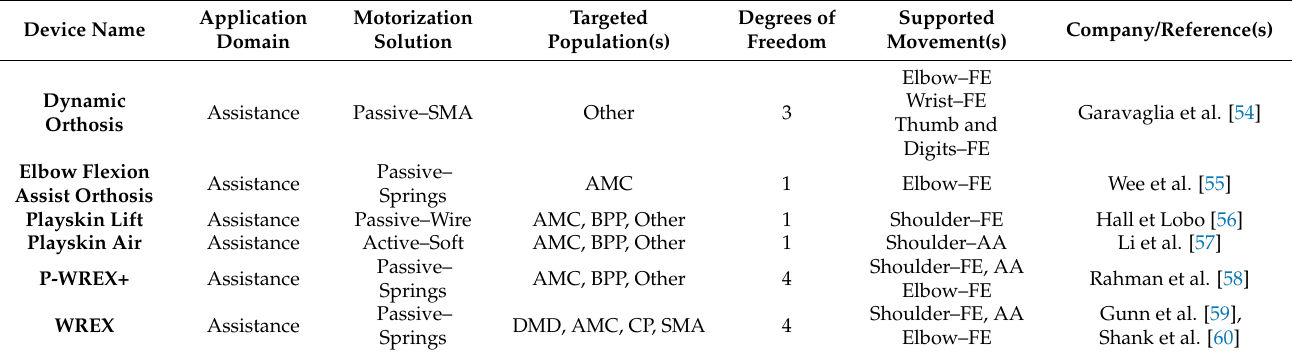
Table 1. Sensorless upper limb exoskeletons in